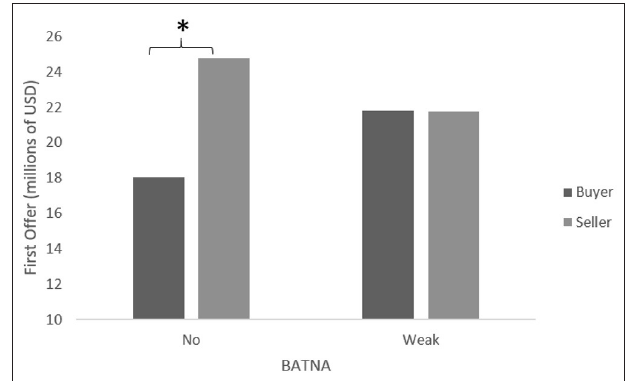
FIGURE 2 | Mean first offer—pharmaceutical plant negotiation. * p < 0.05.